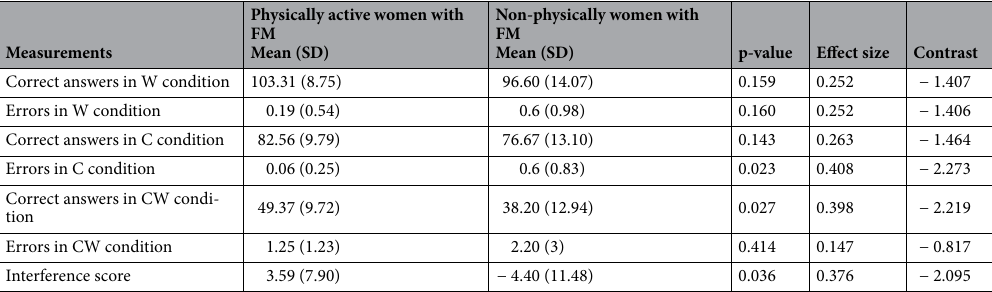
Table 2. Differences between physically and non-physically active women with FM in SCWT performance. W names of colors printed in black, C names different color patches, CW names color-word, where color-word are printed in an incongruous color ink (name the color of the ink instead of reading the word). Interference score was calculated with the following formula: IG = CW − [(W × C)/(W + C)].